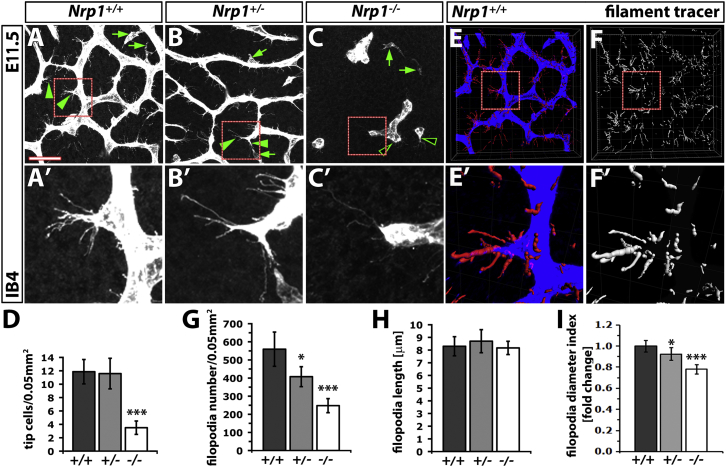
NRP1 Regulates Tip Cell Morphology in a Dose-Dependent Manner(A–C) IB4-labeled E11.5 littermate hindbrains of the indicated genotypes; green arrowheads and arrows indicate examples of tip cells and macrophages, respectively. Scale bar, 50 μm. (A′–C′) Higher-magnification images of the boxed areas in (AC).(D) Quantitation of tip cell number in wild-type and Nrp1 null hindbrains, shown as mean ± SD; Nrp1+/+ and Nrp1+/− n = 7 hindbrains each, Nrp1−/− n = 3 hindbrains; asterisks indicate ∗∗∗p < 0.001.(E and F) Confocal z stack of a wild-type hindbrain, processed with Imaris filament tracer for filopodia analysis. In (E), the vessel plexus and filopodia are shown in blue and red, respectively. In (F), the filopodia tracks are shown in white. (E′ and F′) Higher-magnification images of the boxed areas in (E) and (F).(G–I) Quantitation of filopodia number, length, and thickness index with Imaris filament tracer, shown as mean ± SD, n ≥ 3 hindbrains; asterisks indicate ∗p < 0.05 and ∗∗∗p < 0.001.